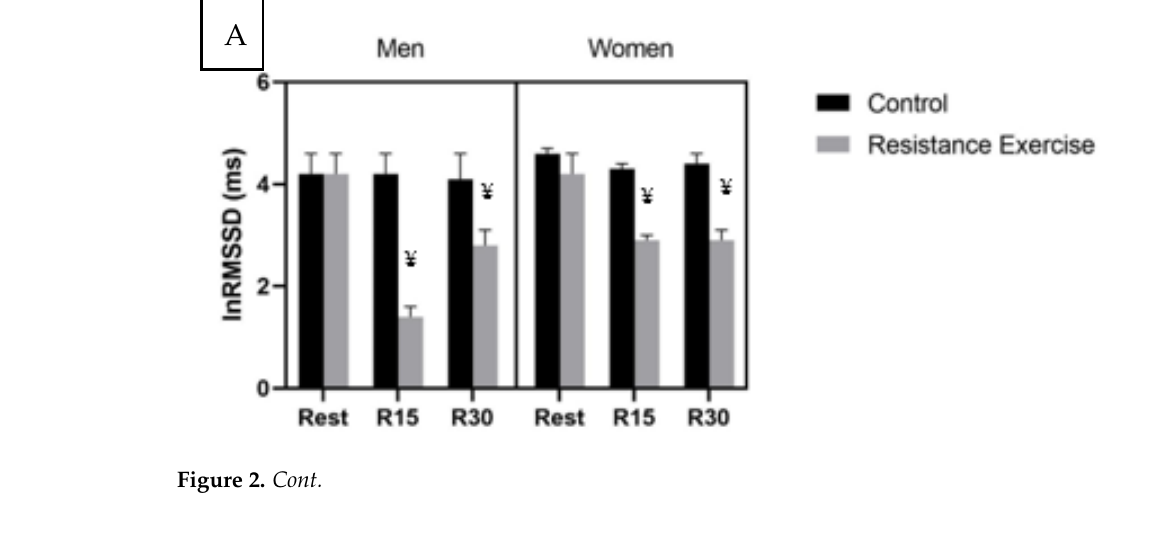
Figure 2. Alterations in vagal modulation (mean ± 95% confidence intervals) measured via ( A ) ln root means square of successive differences (lnRMSSD), ( B ), ln high-frequency power (lnHF), and ( C ) sample entropy at rest, as well as 15 (R15), and 30 min following a control and an acute bout of resistance exercise in resistance-trained men (n = 11) and women (n = 10). Values are mean ± SD. ¥ significantly different from rest ( p = 0.0001), ‡ significantly different from men ( p = 0.03). 4. Discussion The major findings of this study are that (a) there no sex-specific differences for resting values of autonomic modulation when using HRV, but HRC using SampEn demonstrated that men were more complex compared to women at rest, (b) there were significant reductions in vagal tone that were similar between the sexes following the acute bout of resistance exercise, (c) significant increases in sympathovagal balance were also similar between sexes after the acute bout of resistance exercise. Collectively, these data demonstrate that even though SampEn was different at rest between the sexes, suggesting augmented vagal tone in men, autonomic modulation responded similarly between the sexes to the acute bout of resistance exercise. C